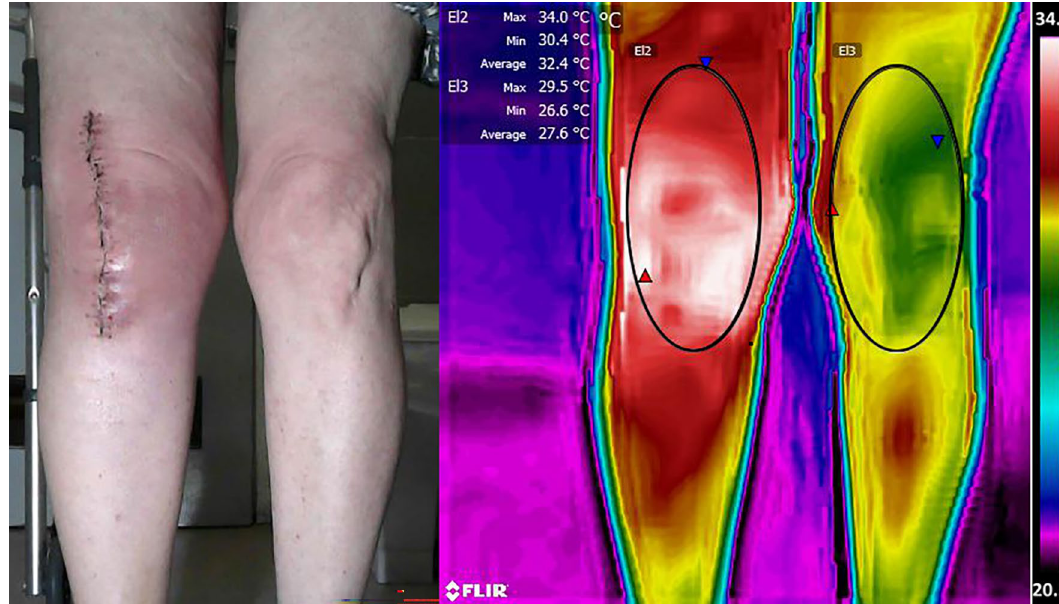
Figure 1. Thermal Imaging Following Total Knee Arthroplasty (TKA). Left : operated right knee 2wks post TKA; Right : thermal image showing elliptical area of measurement around the patella of the operated (R) and unoperated (L) knees. See temperature scale in the margin. Note increased skin temperature (red and white) of the operated knee. These images were from a clinical study (#0251-20-HMO) the PI of which was LK. Informed consent was obtained from the patients as